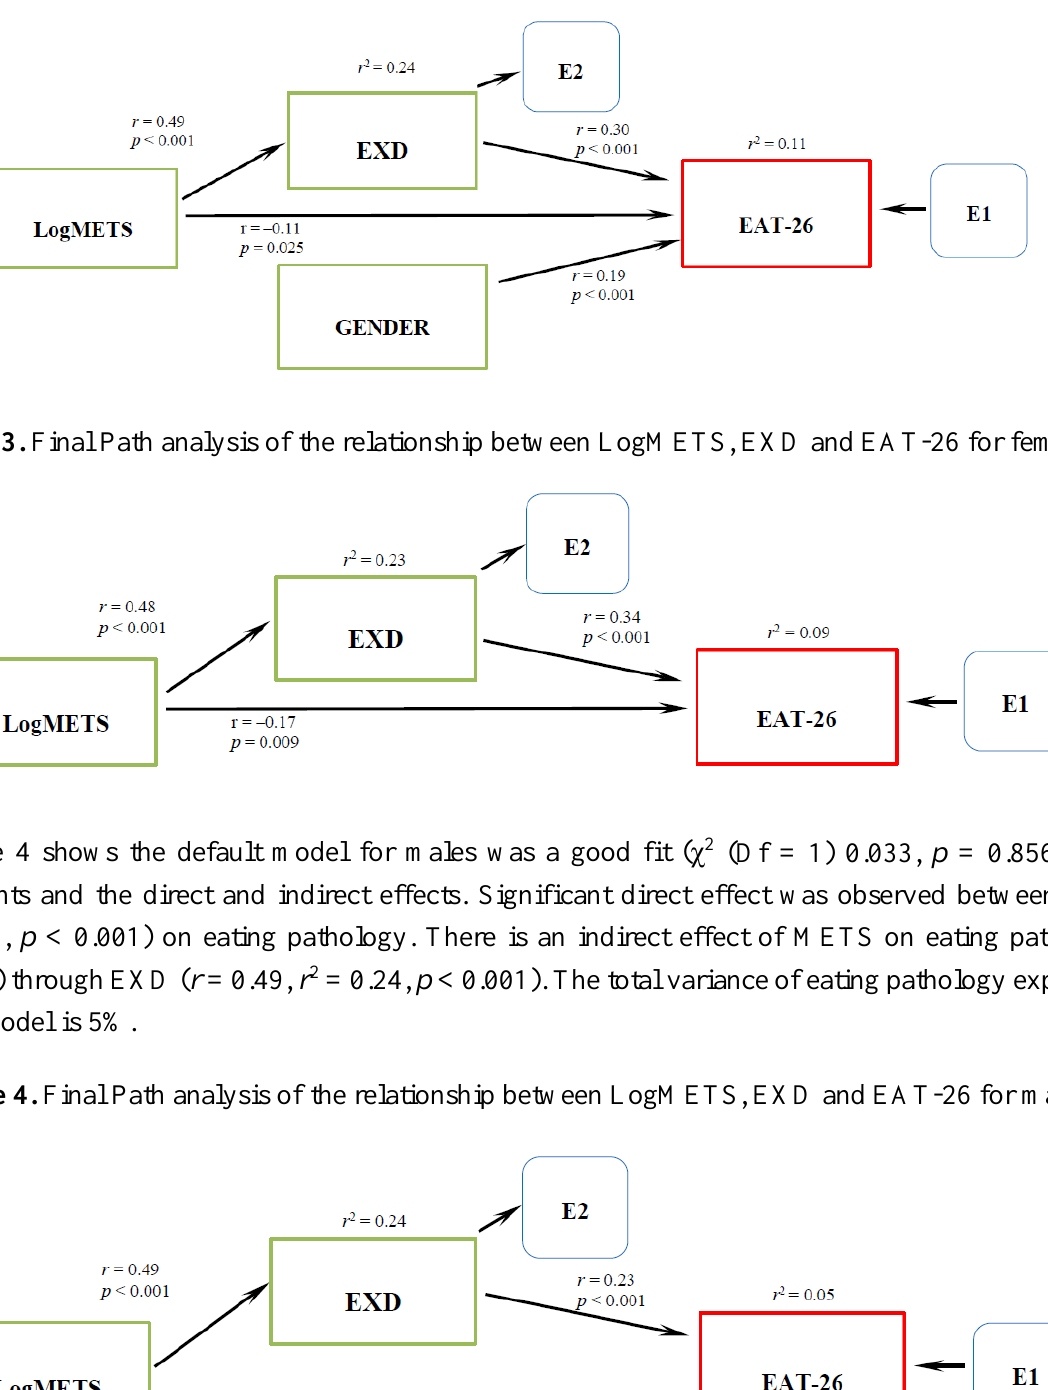
Figure 2. Final Path analysis of the relationship between LogMETS, EXD, gender and EAT-26.